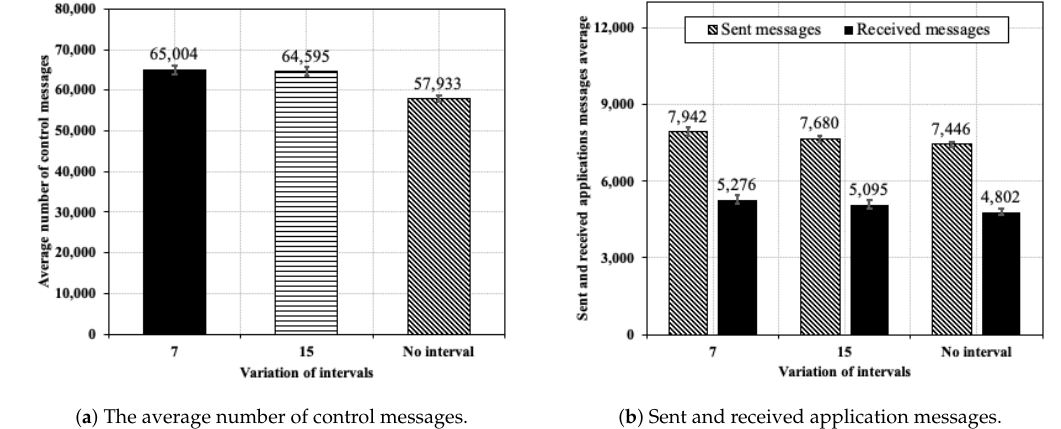
Figure 12. The average number of control messages and sent and received application